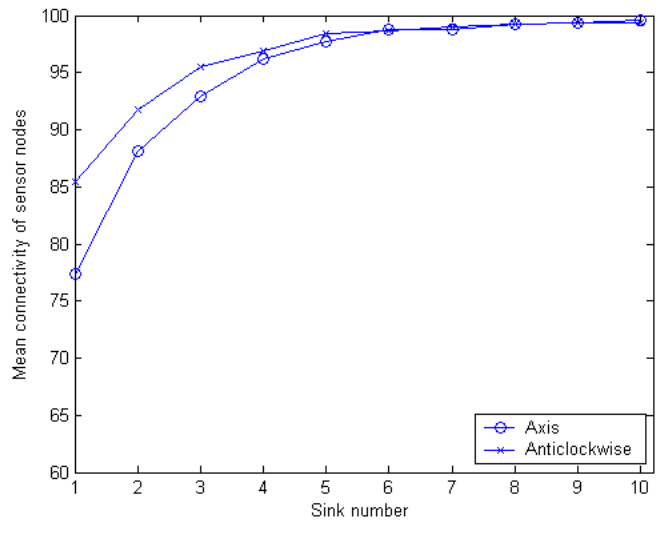
Figure 12. Mean connectivity of MSCWSNs-PC at variety sink number with considering neither MSBSRC nor BCP (mean of 1,000 rounds).